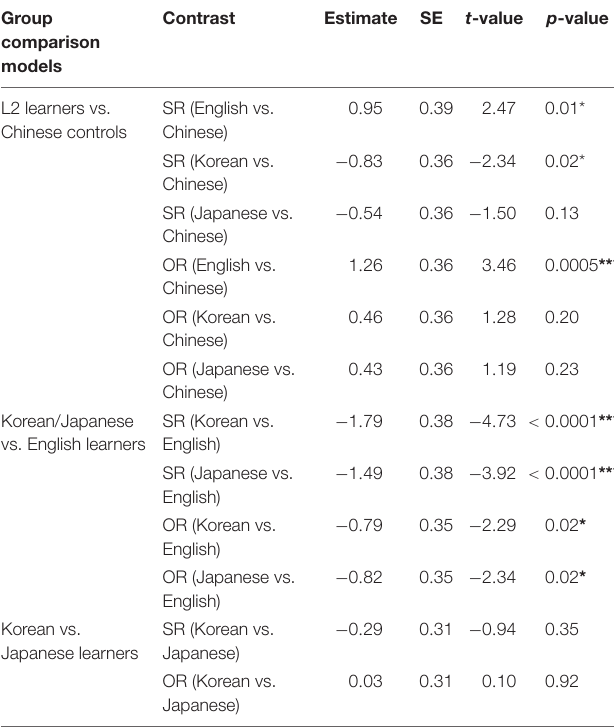
TABLE 5 | Logistic mixed-effects models by group comparison and RC type including all perfect